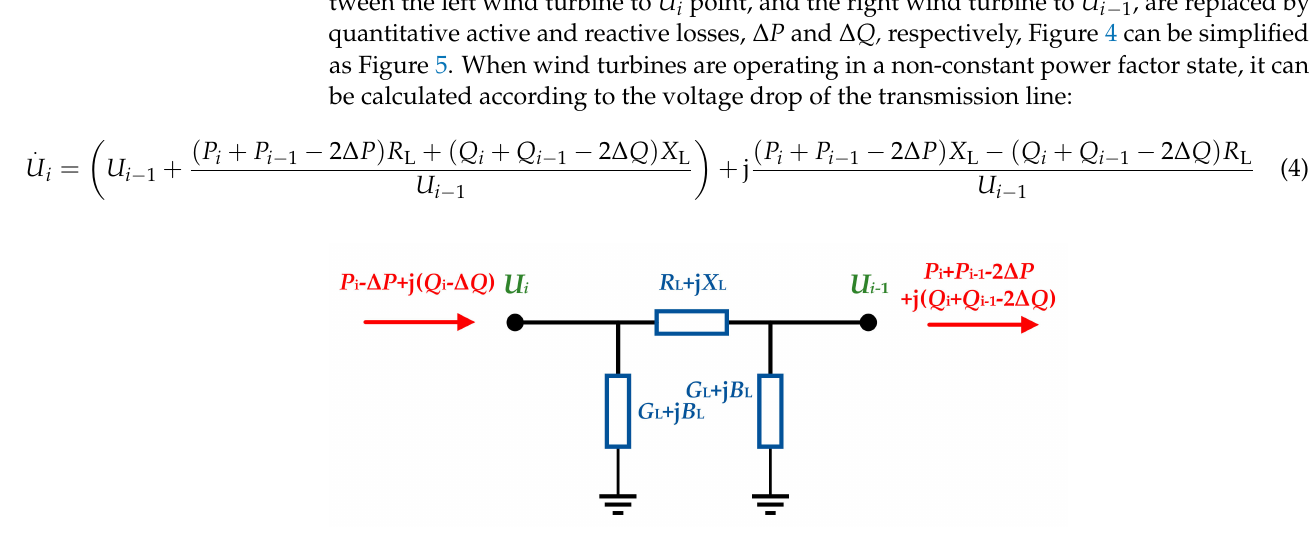
Figure 5. Simplified equivalent circuit of adjacent wind